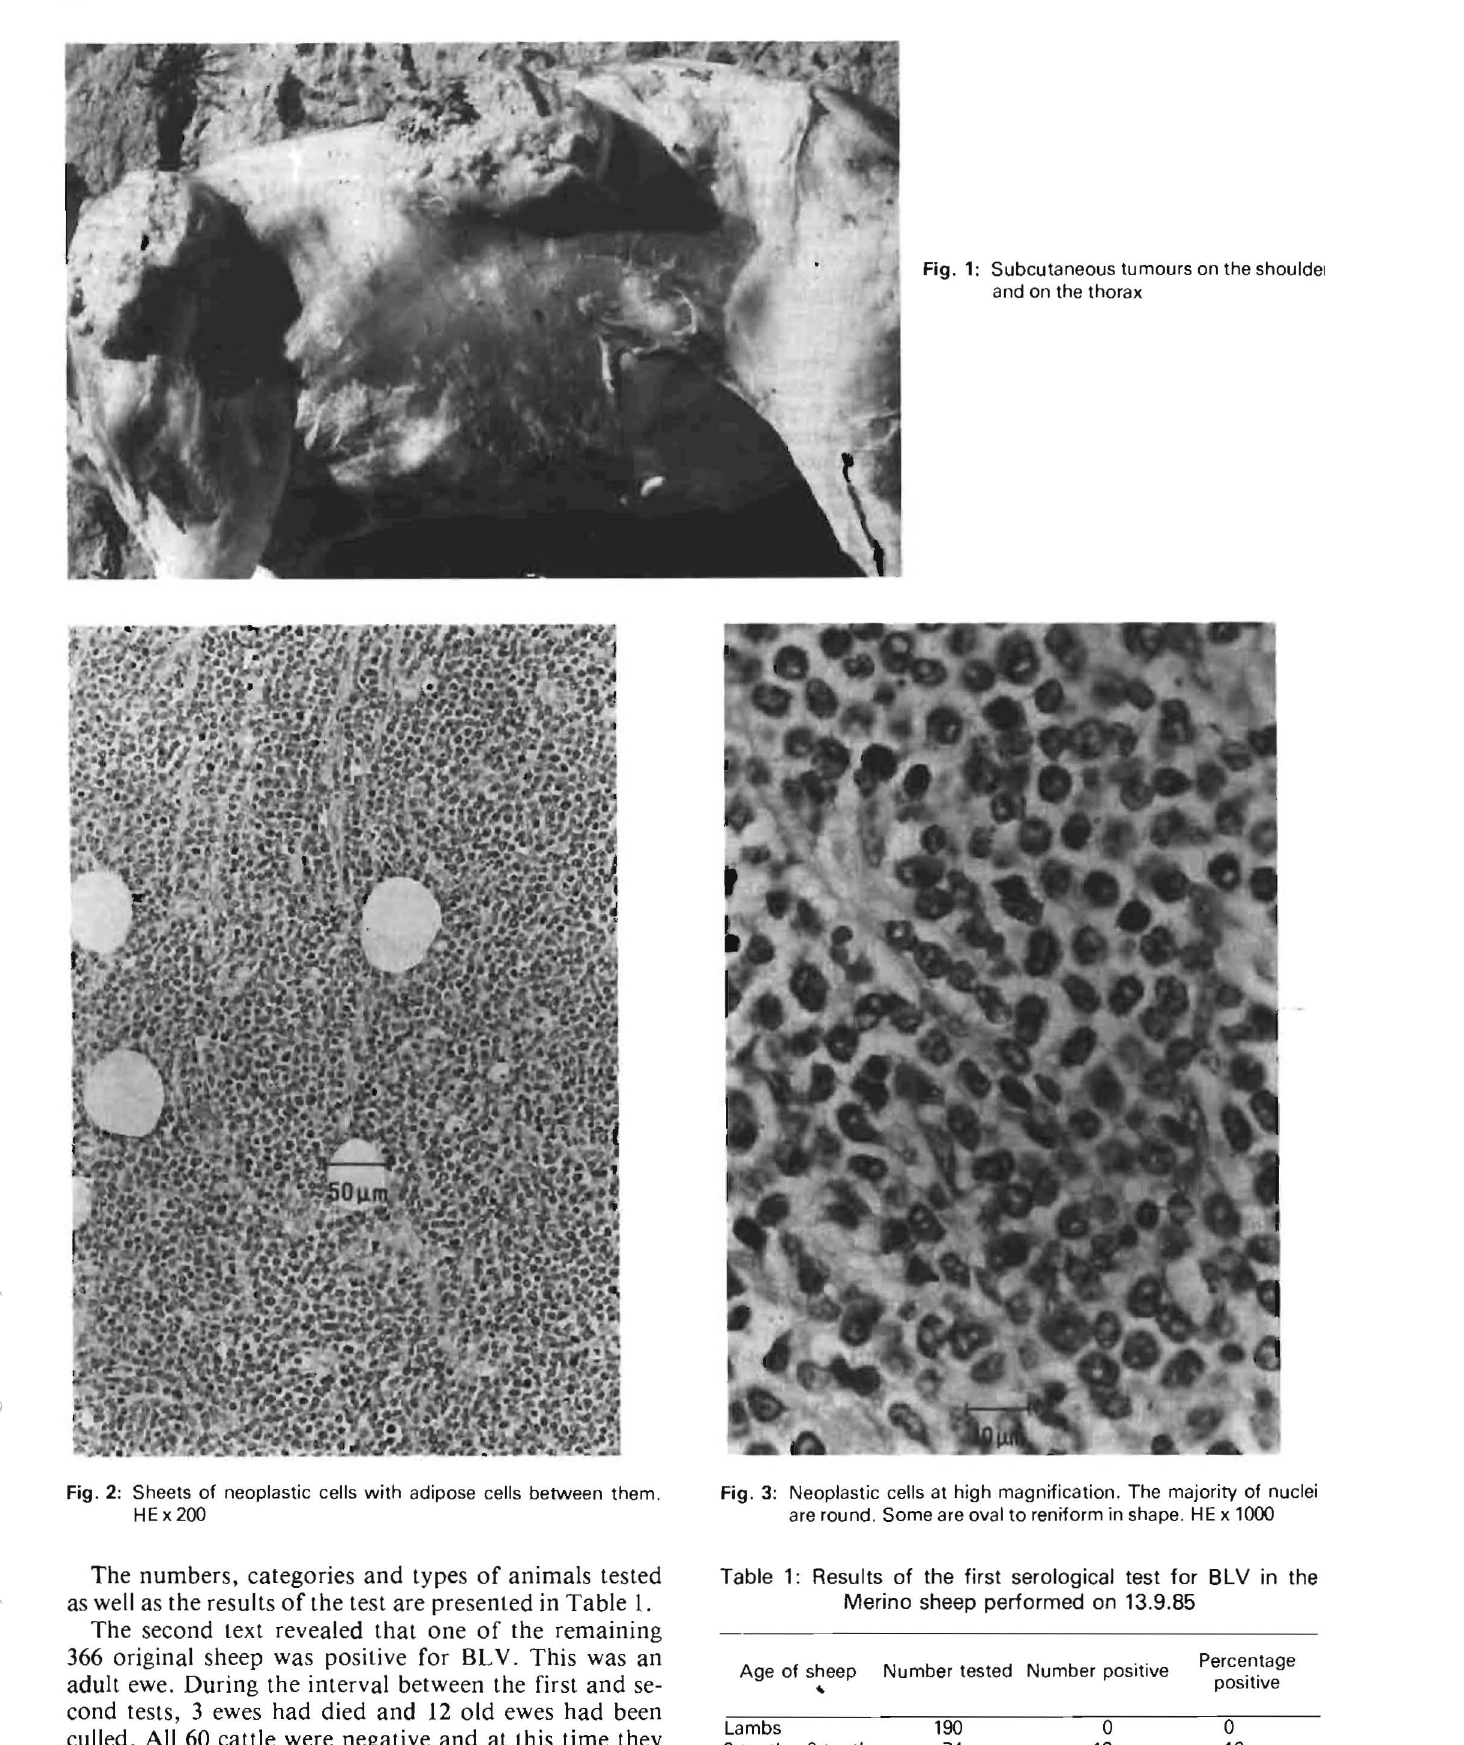
Fig. 2: Sheets of neoplastic cells with adipose cells between them. HEx200 The numbers, categories and lypes of animals lesled